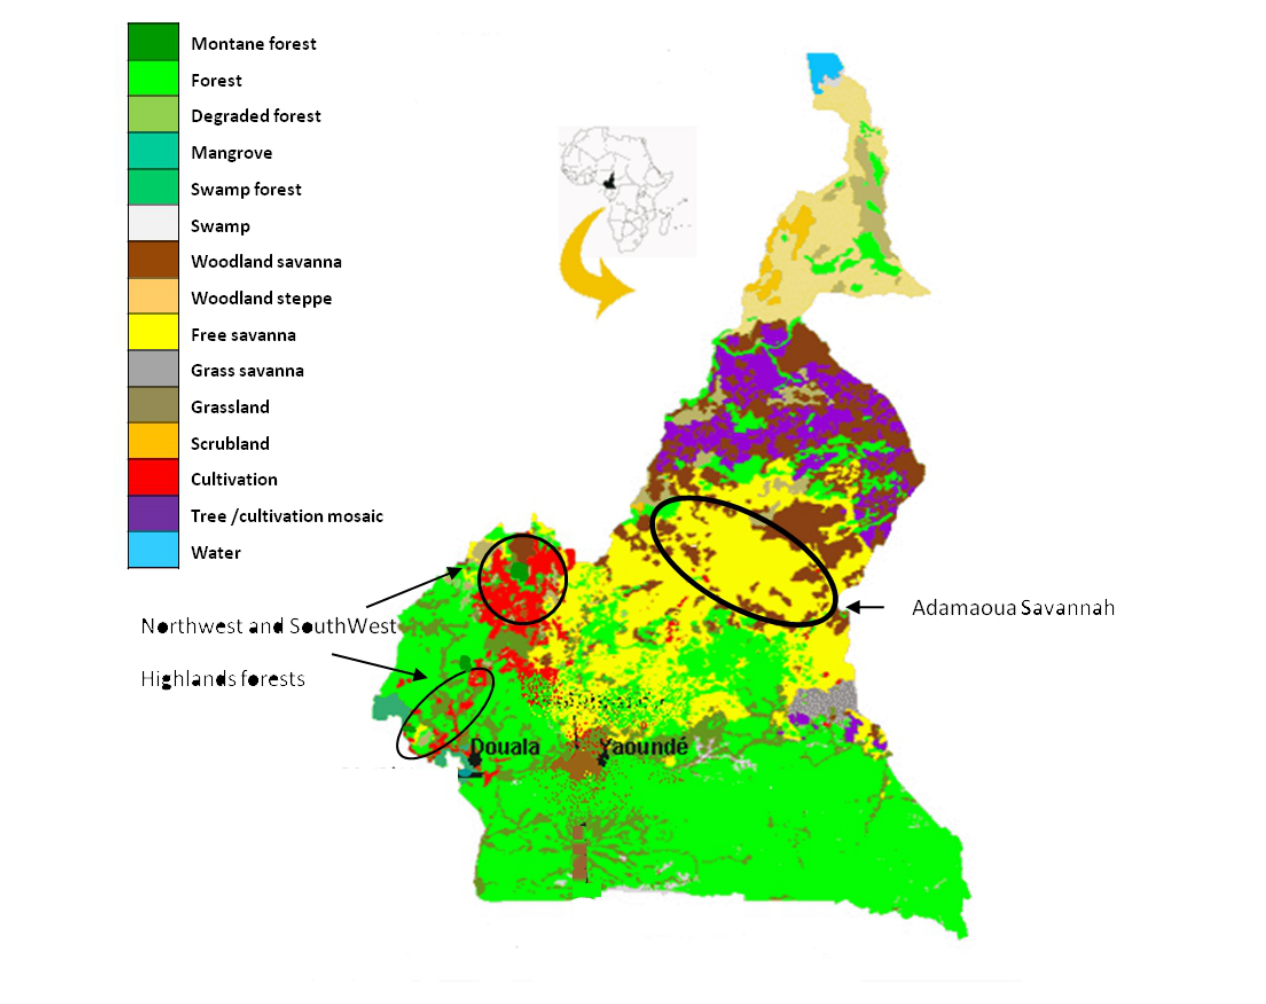
Fig. 1 . Map of main production